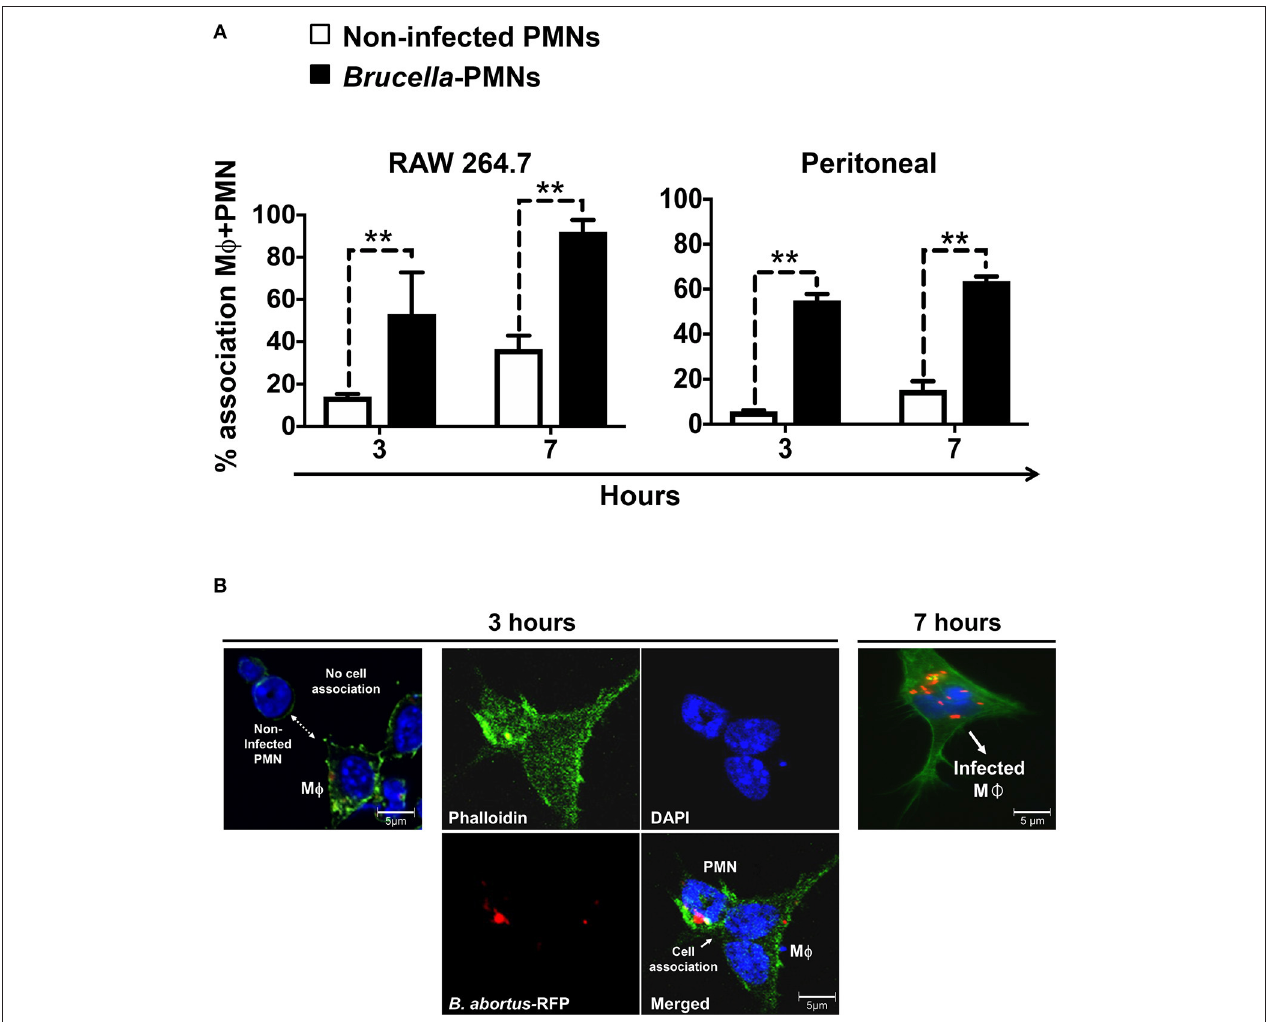
FIGURE 2 | B. abortus -infection increase the association of PMN with M φ s. (A) Non-infected or B. abortus -RFP-infected PMN were incubated with RAW or peritoneal M φ s (1:1) at different time points and PMN-M φ interactions were quantified. Cells were stained (DAPI, for nuclei; phalloidin-FITC for actin filaments), fixed and mounted with MOWIOL. At least 200 PMNs were counted and the percentage of PMN-M φ cell association determined. Values of p < 0.01 (**) are indicated in relation to M φ s incubated with non-infected PMNs. (B) RAW M φ in the process of association and ingestion B. abortus -infected PMN. Infected PMNs are distinguished from other cells by the “donut” shape of their nuclei. Images were photographed under the microscope using the appropriate color filter channel. These experiments were repeated at least three